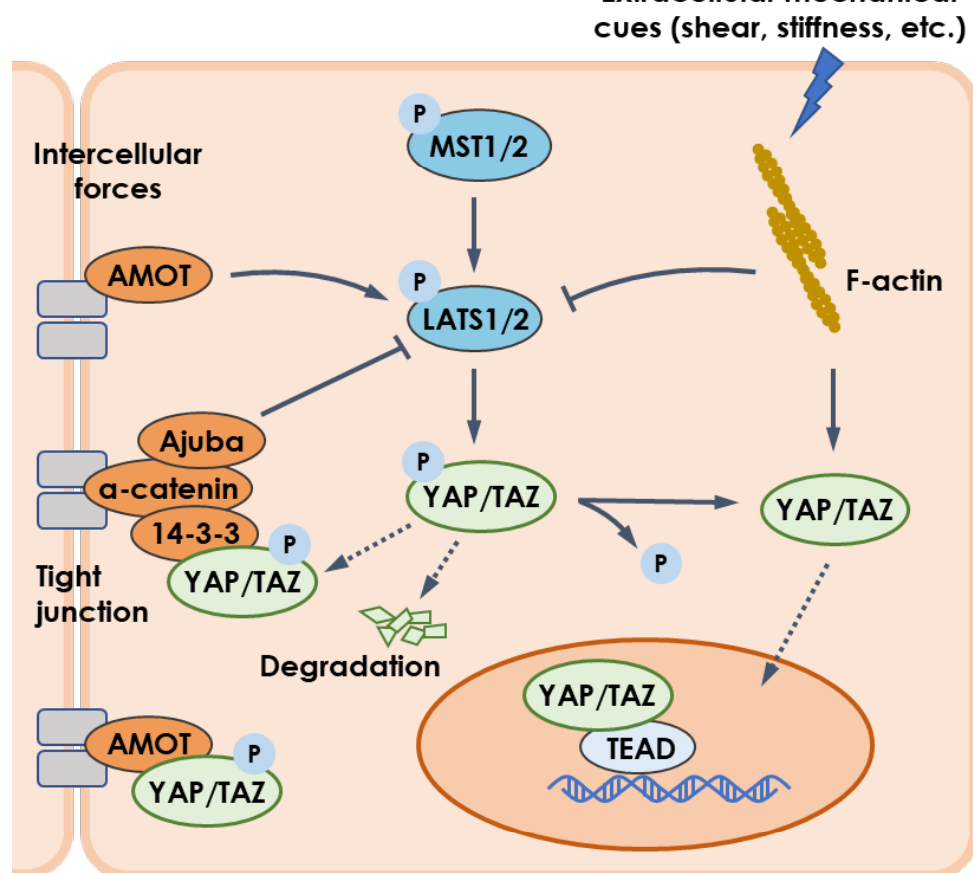
Figure 1. YAP/TAZ pathway regulated by mechanical cues. Intercellular forces enable LATS1/2 to be upregulated by AMOT but inhibited by Ajuba. Mechanical cues such as flow shear and substrate stiffness regulate actin cytoskeleton to activate YAP/TAZ pathway via downregulating LAST1/2 or upregulating YAP/TAZ. Besides, YAP/TAZ is sequestrated in cytoplasm by physical interaction with AMOT. Arrows, blunt ends, and dashed lines indicate activation, inhibition, and translocation, respectively.